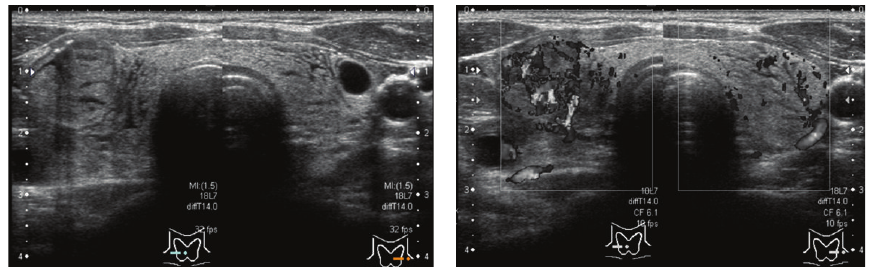
Figure 2: The second echographic examination (performed at symptom onset) showing the bilateral thyroid lobes and a thyroid nodule accompanied by diffuse edematous enlargement and increased internal blood flow.